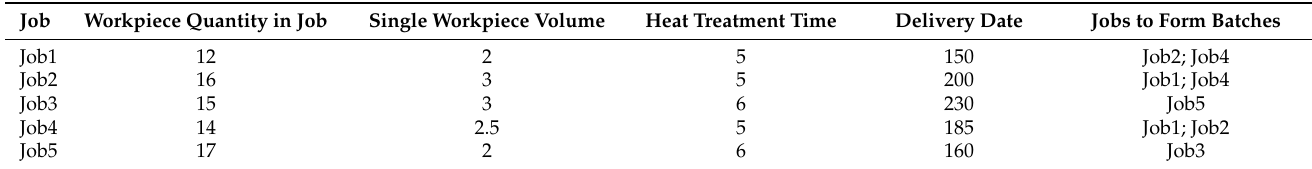
Table 2. Basic data of the decoding rule